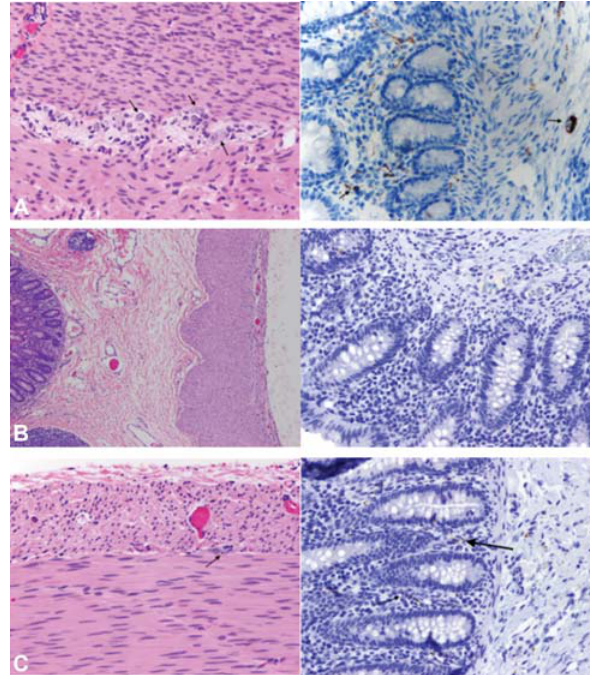
Fig. 5 ( A ) Section of normal ileum (proximal margin) with ganglion cells in the myenteric plexus (hematoxylin and eosin [H&E] left, marked by arrows) and normal expression of calretinin in lamina propria of the mucosa (right, marked by arrows). ( B ) Section of aganglionic segment of the cecum demonstrating absence of gan- glion cells in the submucosal and myenteric plexuses (H&E left) and loss of calretinin expression in lamina propria of the mucosa (right). ( C ) Descending colon with isolated ganglion cell in the myenteric plexus (H&E left marked by arrows) and few nerve fi bers in lamina propria stained with calretinin (right, marked by